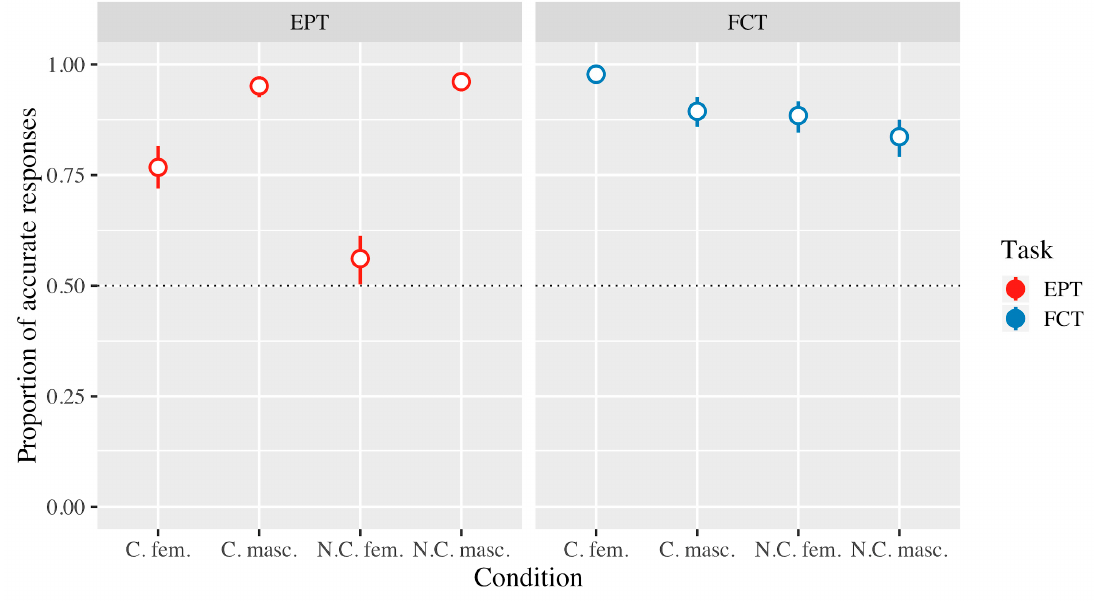
Figure 4. Canonicity and accuracy in gender assignment and agreement. Table 4. Gender assignment production samples.